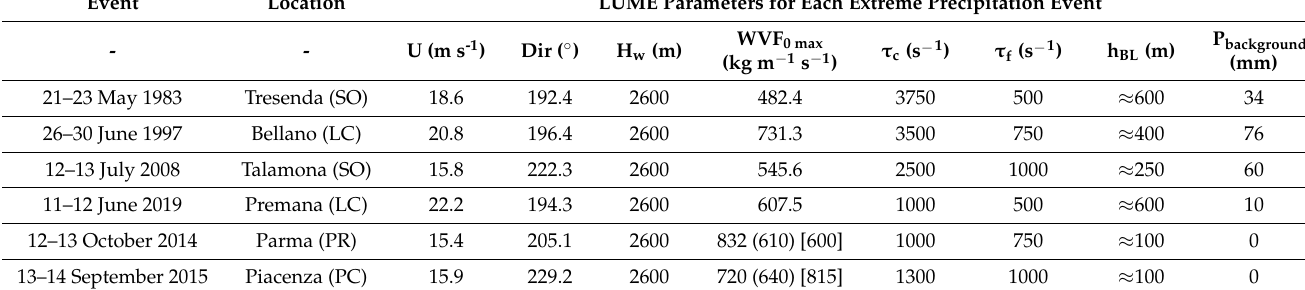
Figure 4. Initial conditions retrieved from radiosonde data regarding ( A ) the WVF0 , ( B ) the PE, ( C )